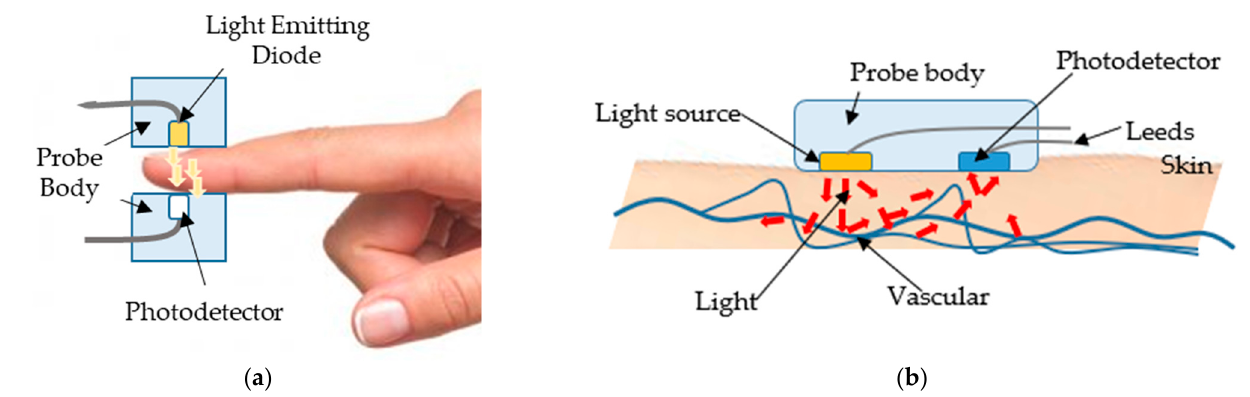
Figure 2. The technique of photoplethysmography (PPG): ( a ) using light transmission property; ( b ) using light reflection Figure 2. Thetechniqueofphotoplethysmography(PPG):( a )usinglighttransmissionproperty; ( b property [25].